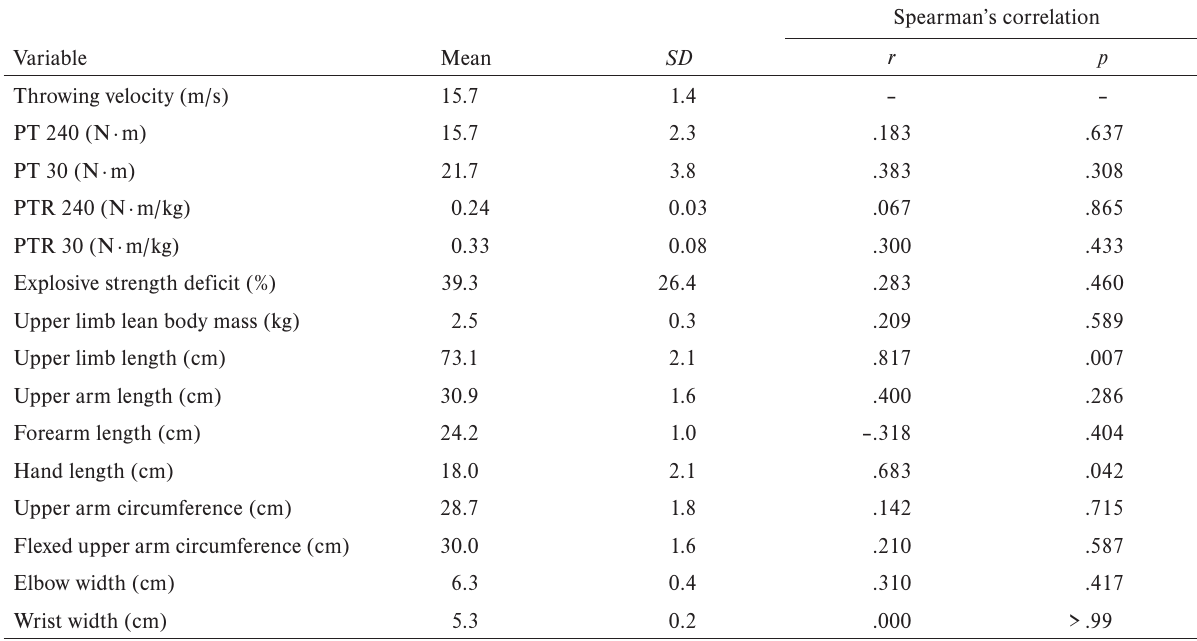
Measured variables and correlations with throwing velocity